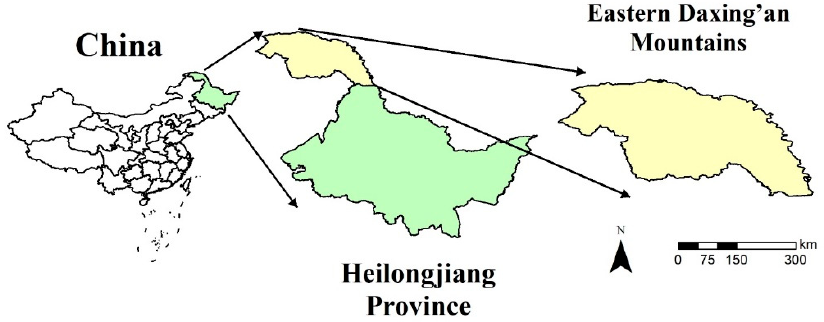
Figure 1. Geographical location of the study area in the Eastern Da Xing’an Mountains, Northeast China.